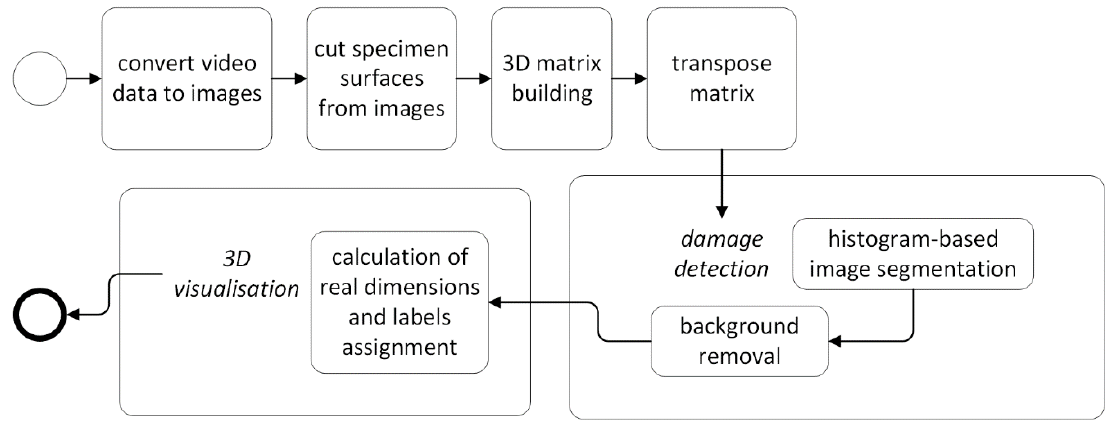
Figure 6. A general reconstruction algorithm for UT B-Scans.